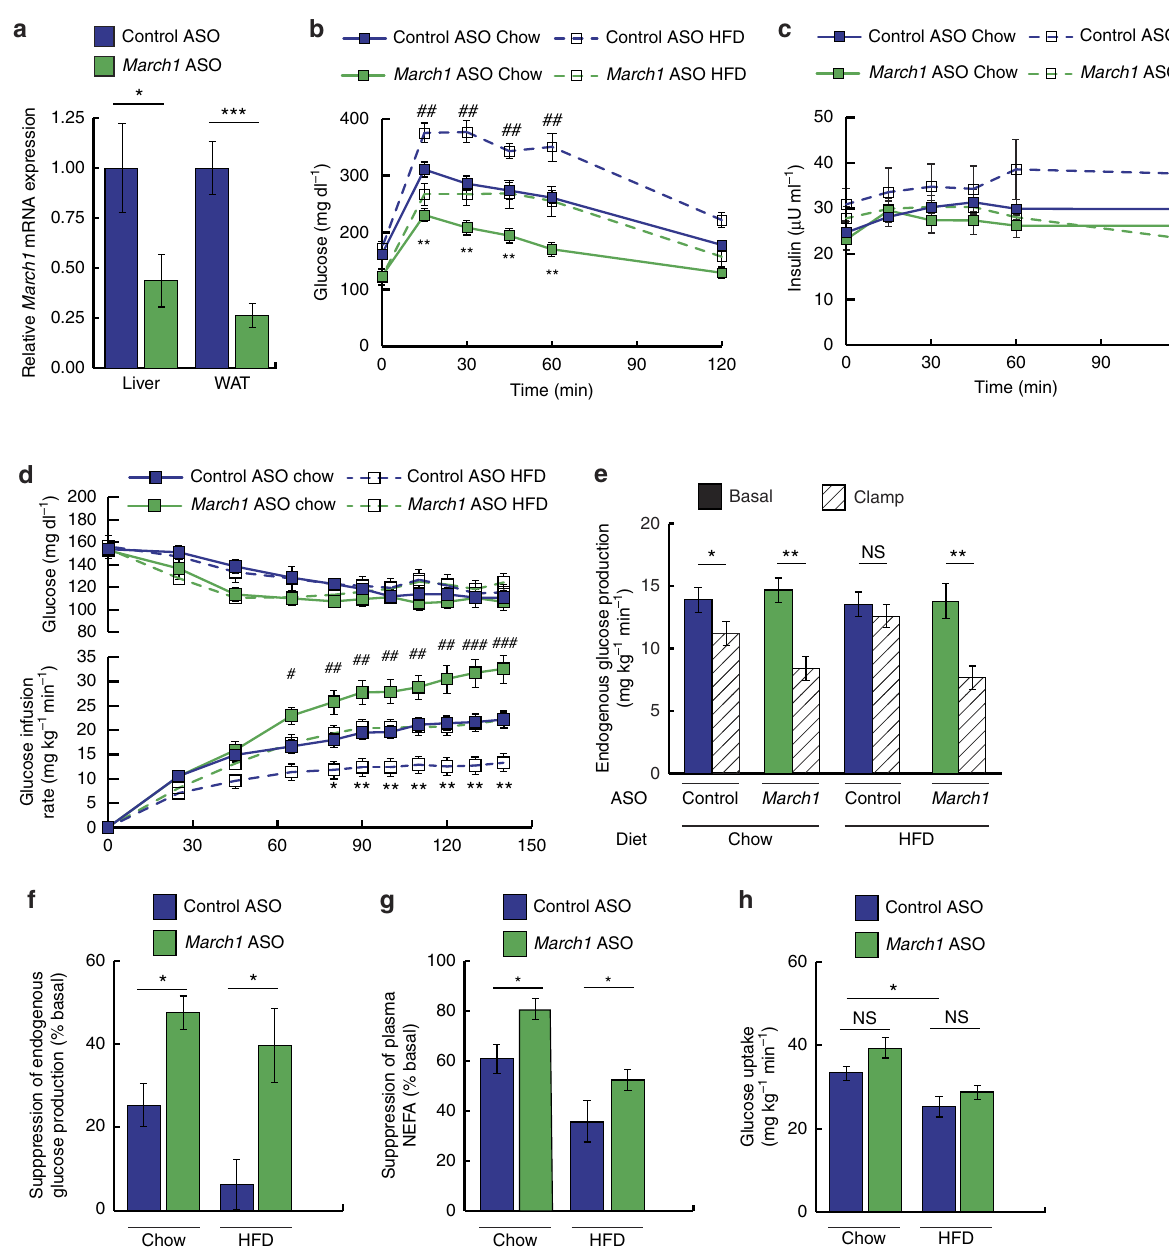
Figure 3 | March1 knockdown improves insulin sensitivity in mice. Male 12–20-week-old C57BL/6J mice were treated with ASO for 2 weeks and fed regular chow or HFD as indicated. ( a ) Relative March1 mRNA expression in liver and WAT. ( b , c ) Plasma glucose ( b ) and insulin ( c ) excursions during ipGTT. ( d ) Plasma glucose and glucose-infusion rates during hyperinsulinemic-euglycemic clamp studies in mice fed regular chow or 3 weeks of HFD and treated with March1 ASO or control ASO. # denotes comparison of chow-fed groups and *denotes comparison of HFD-fed groups. ( e ) EGP during the basal period and during the steady-state period of the clamp. ( f ) Suppression of EGP during the clamp, expressed as % basal EGP. ( g ) Suppression of plasma NEFA concentrations during the clamp, expressed as % basal. ( h ) Whole-body glucose uptake during the clamp. Data are mean ± s.e.m. In all panels, * P o 0.05, ** P o 0.005, ## P o 0.005, *** P o 0.0005, ### P o 0.0005. In a , n ¼ 3 mice per group; comparisons by two-tailed unpaired t -test. In b , c , n ¼ 5–8 mice per group; comparisons by two-way ANOVA. In d – h , n ¼ 9–11 mice per group; comparisons by two-way ANOVA. ANOVA, analysis of variance; ipGTT, intraperitoneal glucose tolerance autoregulation by autoubiquitination 23,26–28 . Consistent with our hypothesis, chow-fed mice receiving March1 AAV required lower glucose infusion rates during hyperinsulinemic-euglycemic clamp studies (Fig. 5c,d and Supplementary Fig. 5a). This decrease was attributable to impaired EGP suppression rather than decreased peripheral glucose uptake (Fig. 5e,f and Supplementary Fig. 5b), indicating that ectopic MARCH1 expression is sufficient to (Fig. 5a,b)—consistent with its known post-translational impair insulin action in mouse liver. Body weight was similar